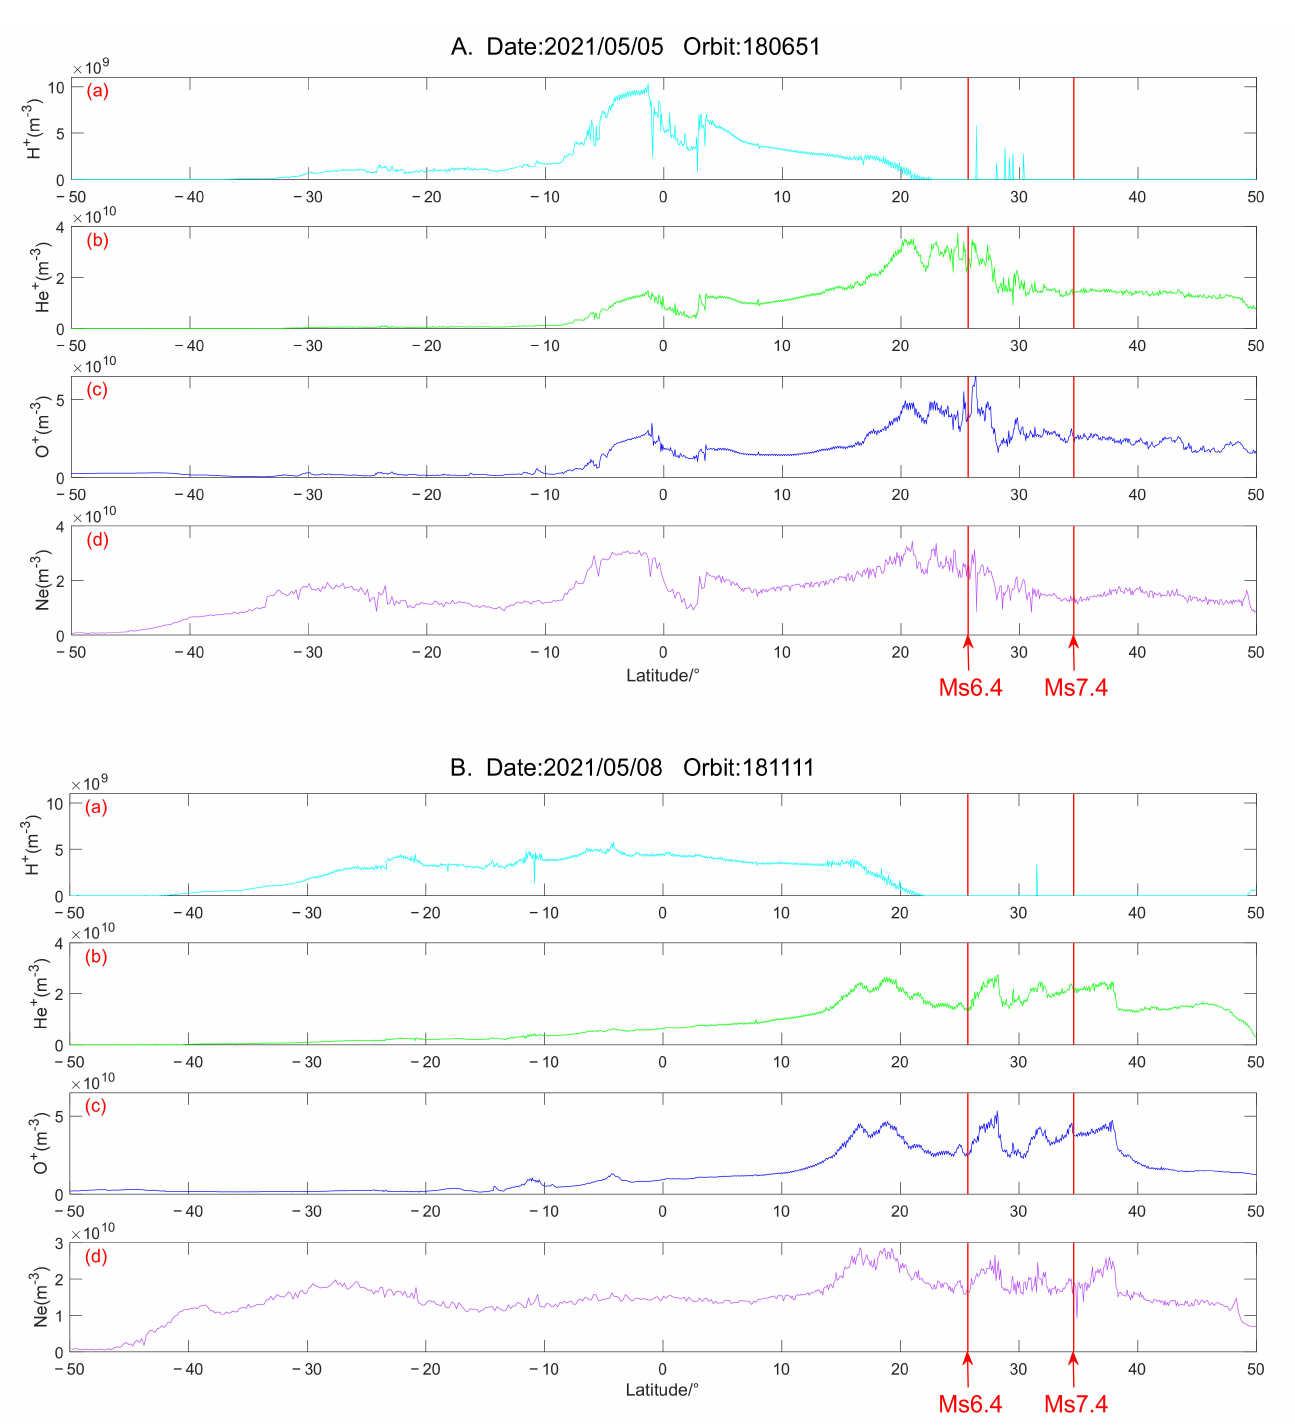
Figure 8. Anomalies of ion density. In each figure ( A , B ), the subfigure ( a – d ) represent H + , He + , O + , and Ne data, respectively, with the unit in m − 3 . The red lines indicate the latitude of the